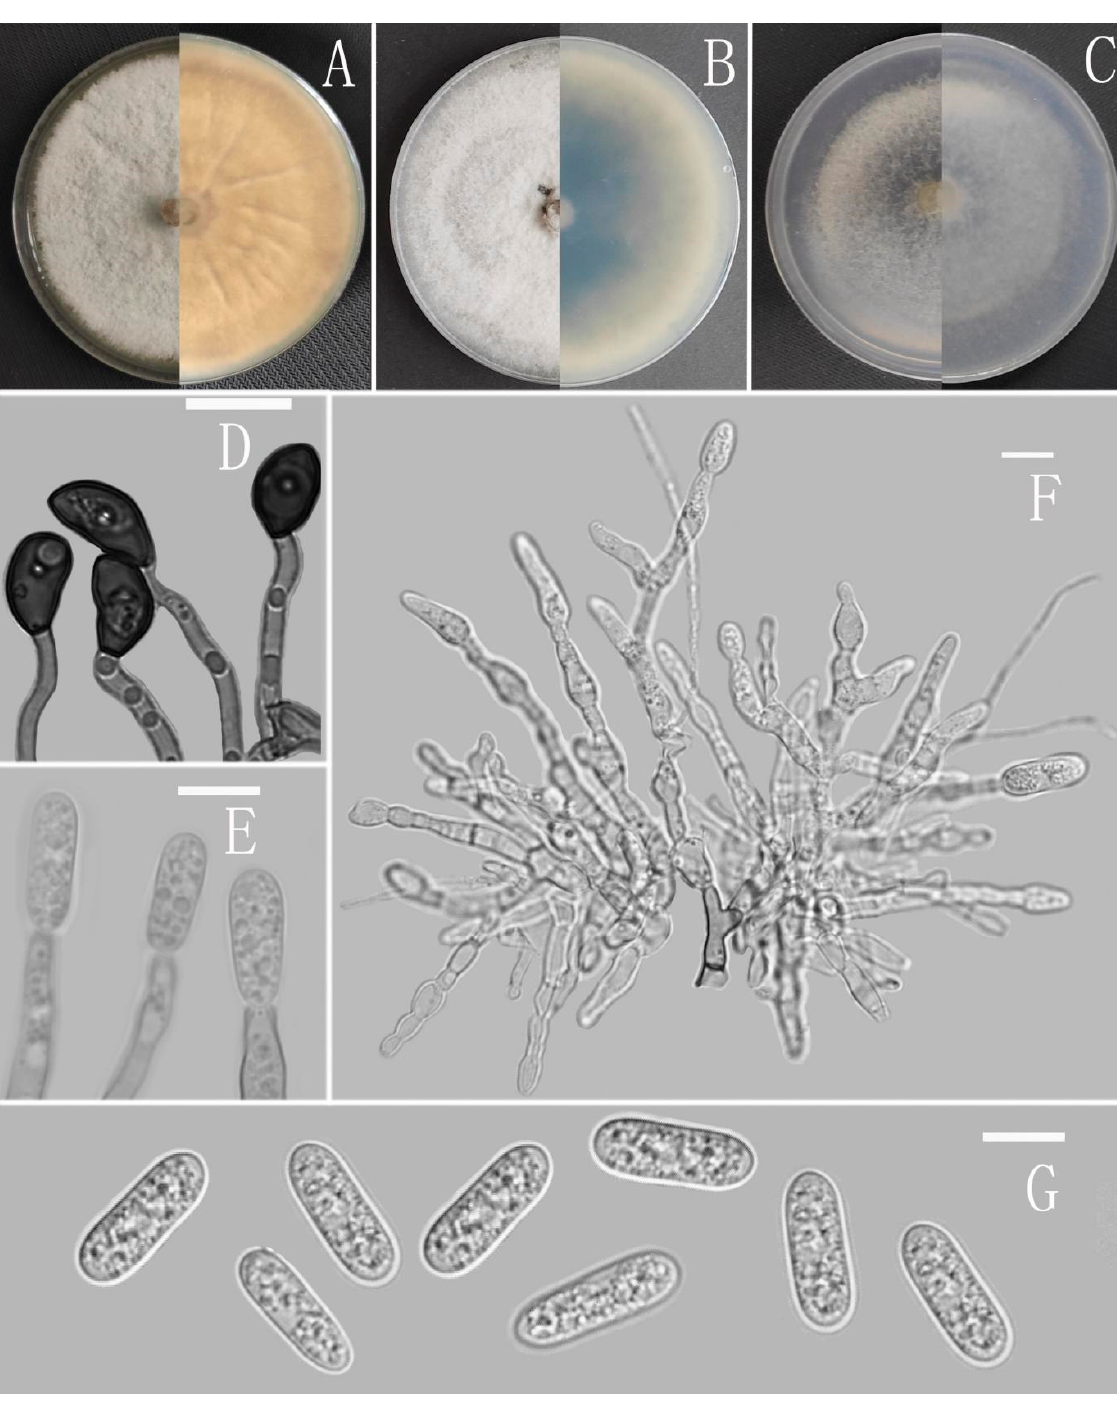
Figure 5. Colletotrichum dimorphum (YMF 1.07309). ( A – C ) Colonies on media above and below after 7 days at 25 °C (( A ) MEA; ( B ) PDA; ( C ) SNA). ( D ) Appressoria. ( E ) Conidiophores. ( F ) Conidiophores and Conidia. ( G ) Conidia. Scale bars: ( D – G ) = 10 μ m.